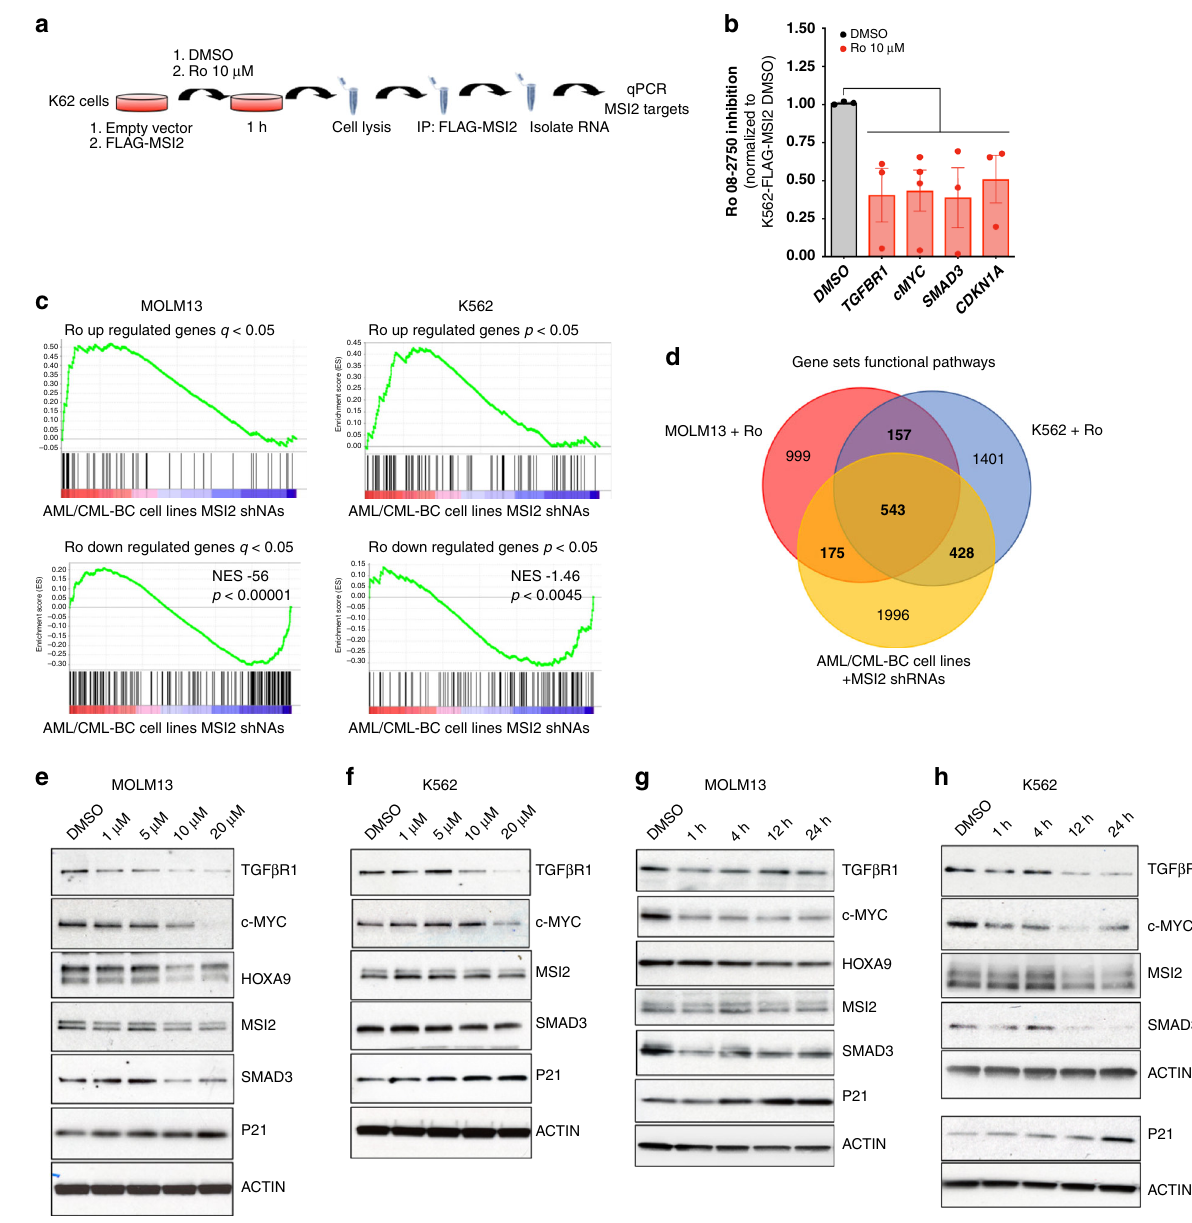
Fig. 5 Ro 08 – 2750 treatment corresponds with MSI2 shRNA depleted gene signature. a Scheme of RNA-immunoprecipitation (IP) protocol followed with K562-MIG (MSCV-IRES-GFP) or FLAG-MSI2 overexpressing cells. b Ro 08 – 2750 inhibitory effect in the RNA-IP enrichment of MSI2 mRNA targets in K562-FLAG-MSI2 versus K562-MIG after 1 h treatment at 10 μ M. Data is shown as average of inhibition effect (normalized to DMSO cells) ± s.e.m. of four independent experiment. c Upregulated and down-regulated gene sets obtained by RNA-seq analysis after 20 μ M Ro 4 h treatment in MOLM13 and K562 cells showing identical signature as previously obtained using shRNA against MSI2 in CML-BC and AML lines 27 . d Venn diagram showing gene Set Enrichment Analysis (GSEA) overlap between MOLM13 ( red ), K562 (blue) (after 20 μ M Ro 4 h treatment) and AML/CML-BC cell lines MSI2 depleted with shRNAs ( yellow ) from Kharas et al. 27 . Bold values inside brackets below each grup are total gene sets numbers. e Representative immunoblot for MOLM13 treated with Ro at different concentrations (1, 5, 10, and 20 μ M) for 4 h showing expression of MSI2 targets. HOXA9 is not expressed in this BCR-ABL + (CML-BC) leukemia cell line. f Representative immunoblot for K562 treated with Ro at different concentrations for 4 h showing expression of MSI2 targets. g Representative immunoblot for MOLM13 treated with Ro 20 μ M at different time points (1, 4, 12 and 24 h) showing expression of same MSI2 targets as in panel e . h Representative immunoblot for K562 treated with Ro 20 μ M at different time points with an effect on MSI2 targets. P21 and β -ACTIN from a different representative gel are shown. Source data are provided as a Source Data fi transplantation (Fig. 6d). Ro administration every 3 days was well achievable due to limited compound solubility and the use of tolerated (Supplementary Fig. 8a) with mice exhibiting little to no weight loss and equivalent red blood cell, platelet, mean cor- puscular volume, hematocrit, and hemoglobin counts compared (Fig. 6a – c). To determine if Ro treatment could effect disease with the non-treated group (Supplementary Fig. 8b – f). Using burden, we next treated a second cohort of animals and mon- itored them for disease progression for 19 days after healthy mice, we also reported no changes in liver enzymes 24 h